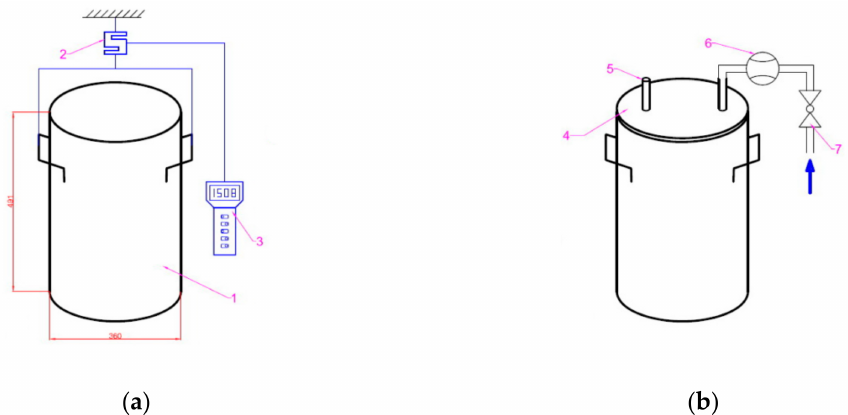
Figure 1. Scheme of the measurement setups: ( a ) for bulk density, ( b ) for the conversion factor: 1—measuring container, 2—load cell, 3—recorder, 4—lid, 5—air escape, 6—electronic flow meter,